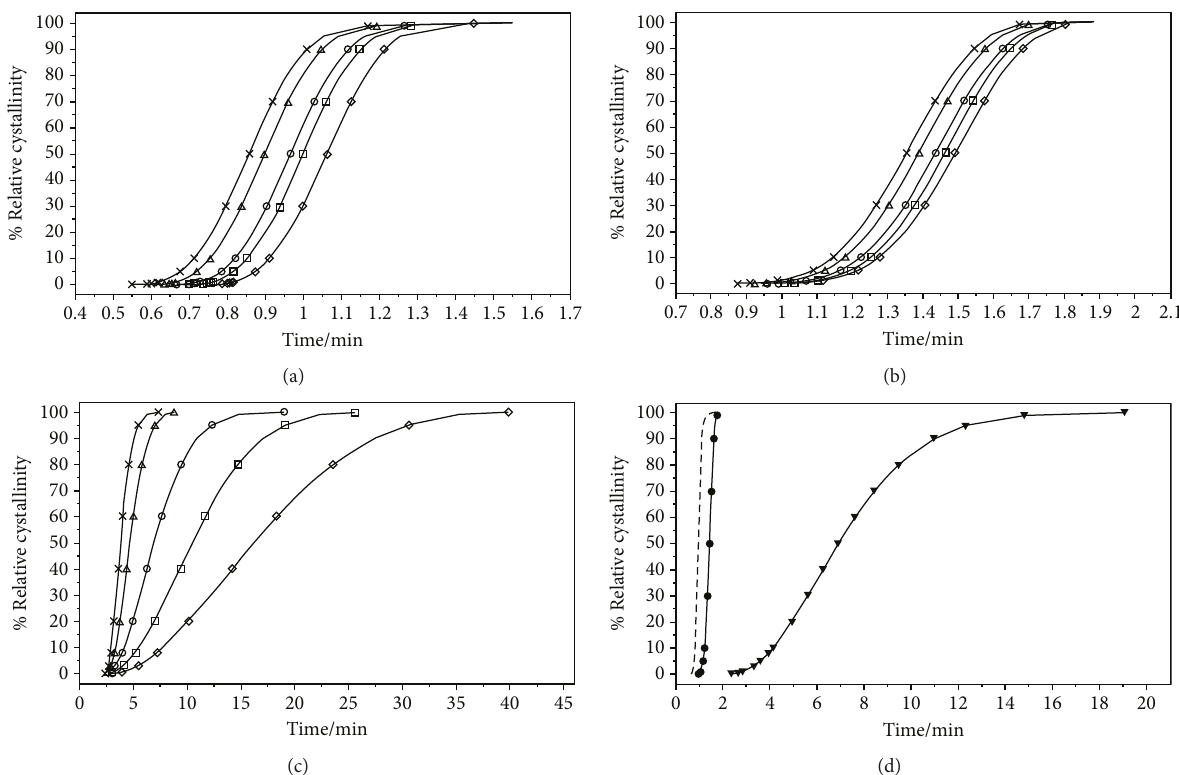
Figure 7: Relative Crystallinity (%) as a function of time (min) for: (a) linear poly ( ε -caprolactone) PCL, (b) SCL2, (c) HEMACL3. Symbols: ( × ) T =16 ° C, ( Δ ) T =18 ° C, ( ○ ) T = 20 ° C , ( □ ) T = 22 ° C , and ( ◊ ) T = 24 ° C . (d) Linear PCL, SCL2, and HEMACL3 copolymers, crystallized c c c c c = 20 ° C , symbols: ( − ) linear PCL, ( ● ) SCL2, and ( ▼ ) HEMACL3. at T c